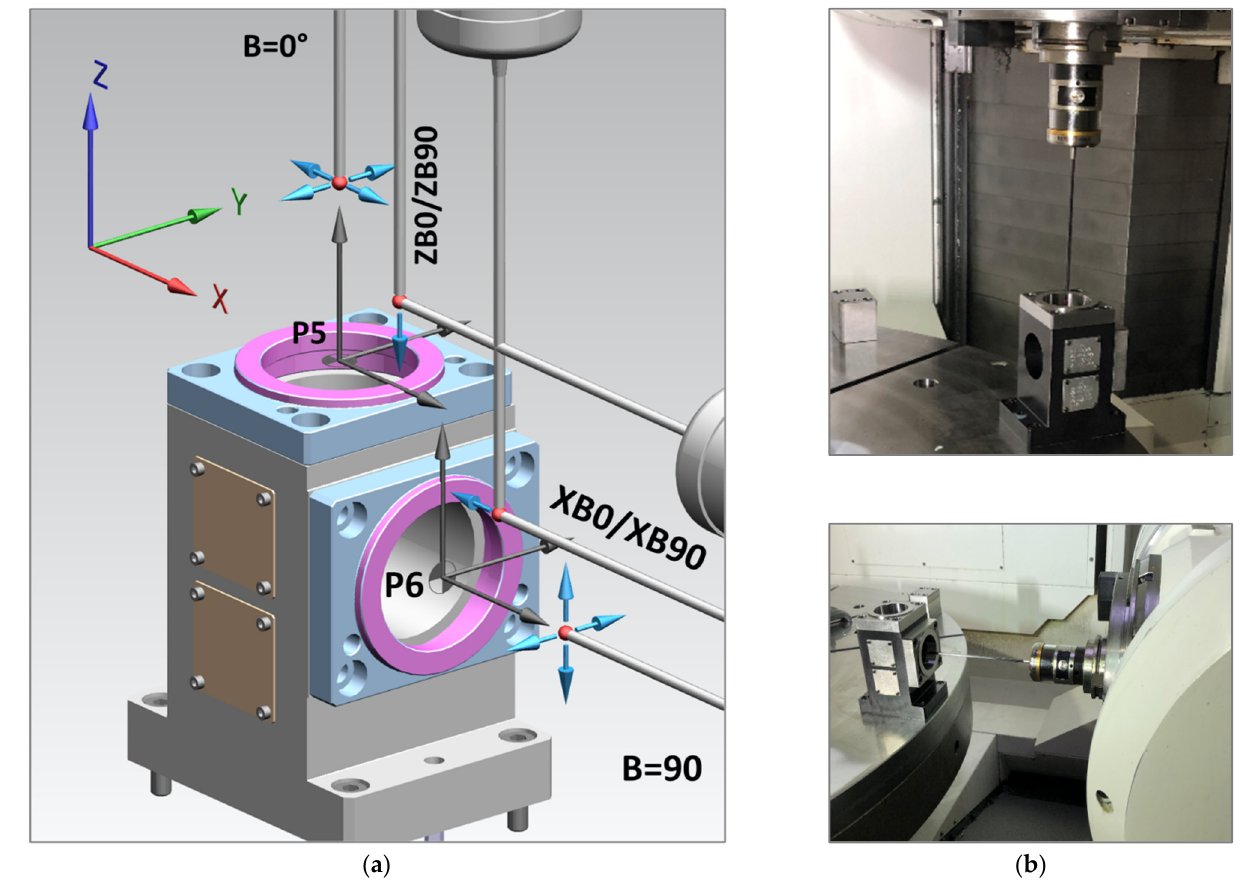
Figure 9. Visualization of artifact probing sequence procedure: ( a ) TTP stylus approach for each of the measurement areas and points; ( b ) MT measurement examples with T1 TTP configuration vertical B 0° position and horizontal B 90°, artifact built in special calibration fixture with periodic validation.